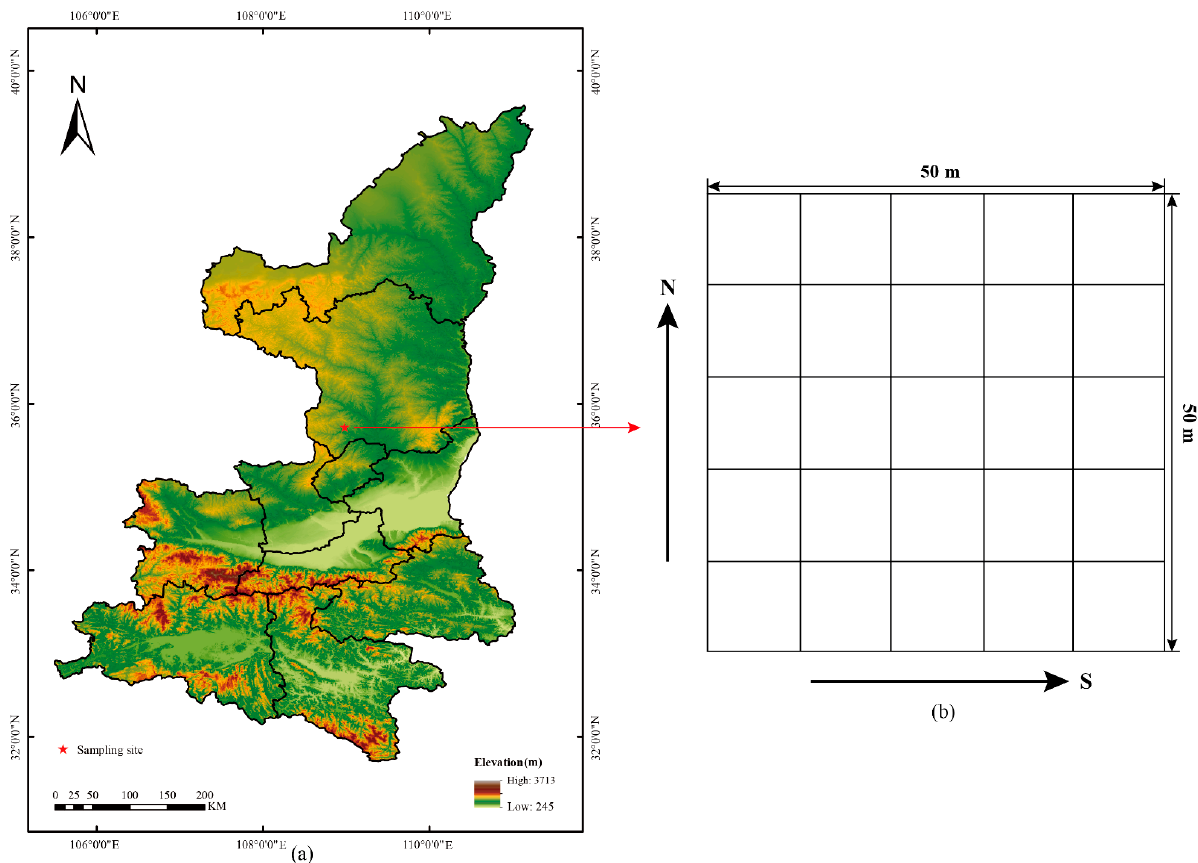
Figure 1. Map of the study area showing ( a ) the sampling site in an elevation map of the administrative regions of the Shaanxi Province, and ( b ) the layout of the plot and quadrats.